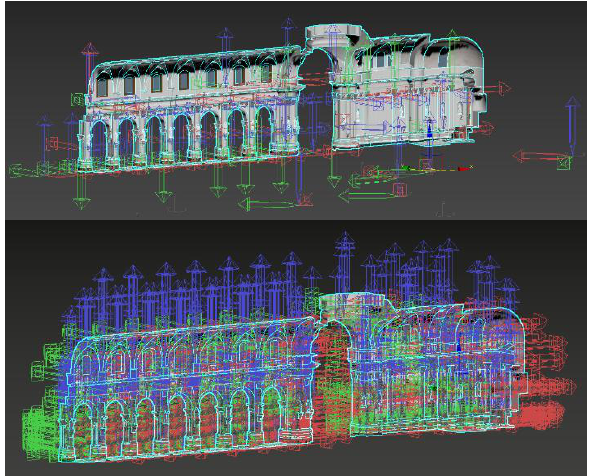
Figure 8: Comparison between the 18 th century Cathedral and today's one: wireframe and shaded view of the polygonal model.